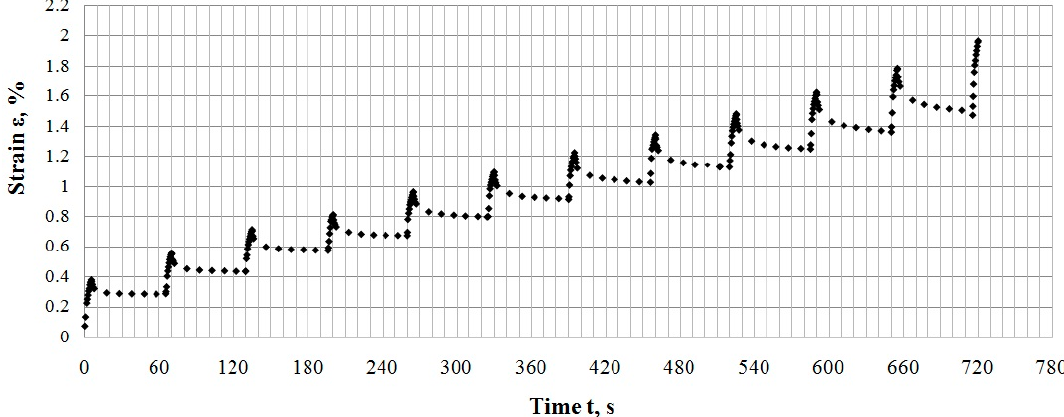
Figure 2. Cyclic strain of asphalt concrete: 11 full cycles before failure.